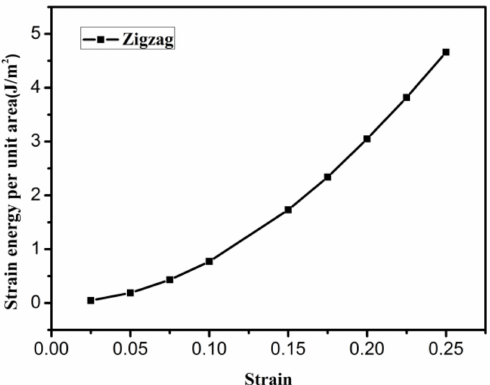
Figure 5. The strain energy per unit area of pristine graphene.